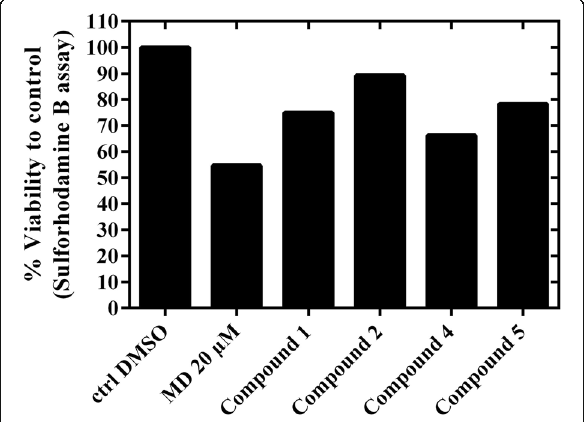
Fig. 4 Protection of Hepa-1c1c7 cells against menadione-induced cytotoxicity . Hepa-1c1c7 cells were pretreated with either DMSO or 3.125 μ M from indicated compounds for 24 h before being intoxicated with 20 μ M of menadione (MD) for a further 24 h. Cell monolayers were then fixed with TCA for 1 h and processed for SRB cytotoxicity assay. Data are means of at least quadrate treatments for each concentration